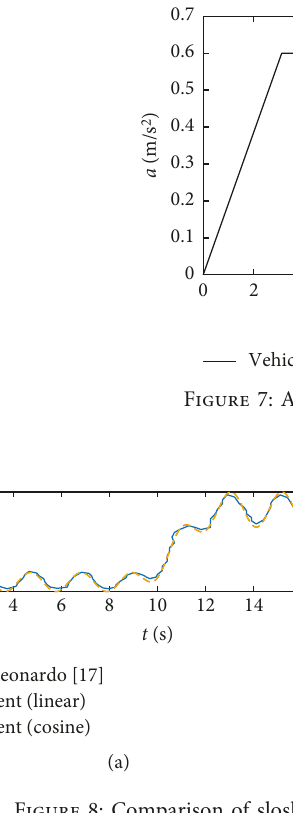
Figure 8: Comparison of sloshing force and moment: (a) sloshing; (b) sloshing